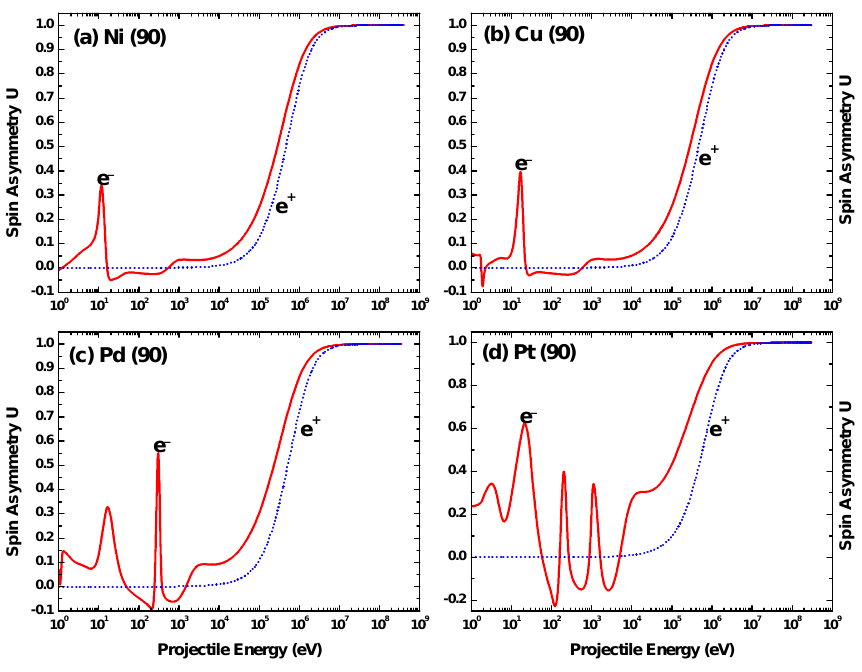
Figure 26. Energy variation of the spin asymmetry parameter U for both electron (—-) and positron ( · · · · · · ) impact scattering from ( a ) Ni 58 , ( b ) Cu 63 , ( c ) Pd 108 , and ( d ) Pt 196 at scattering angle θ = 90 ◦ .